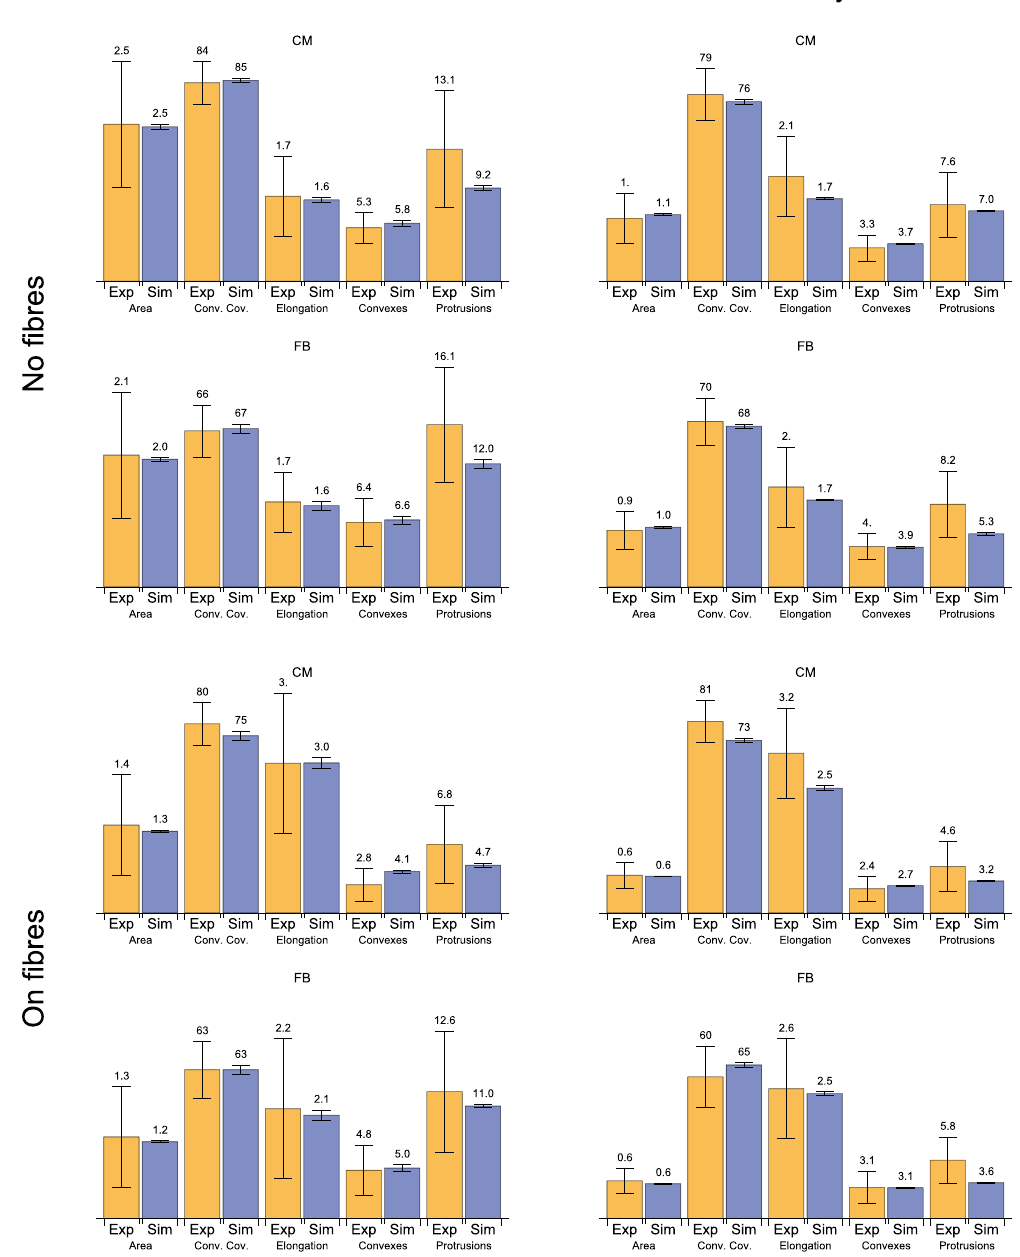
Figure 5. Comparison of the parameters in the experiment and the simulation. Yellow bars show experimental values, whereas the blue ones show computed values. The amount of cells studied in experiment and considered in this statistics are listed in Table 1, in simulations–in Table 2. Error bars indicate standard